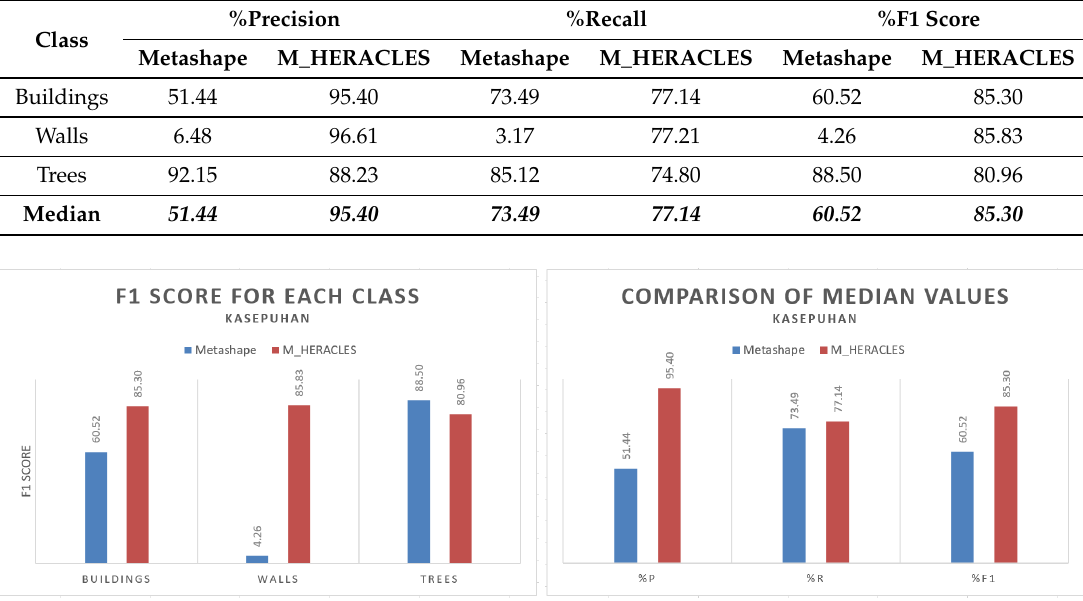
Figure 7. Histogram representation of the classification performance for each class in the Kasepuhan dataset ( left ) and the median value of the principal quality parameters ( right